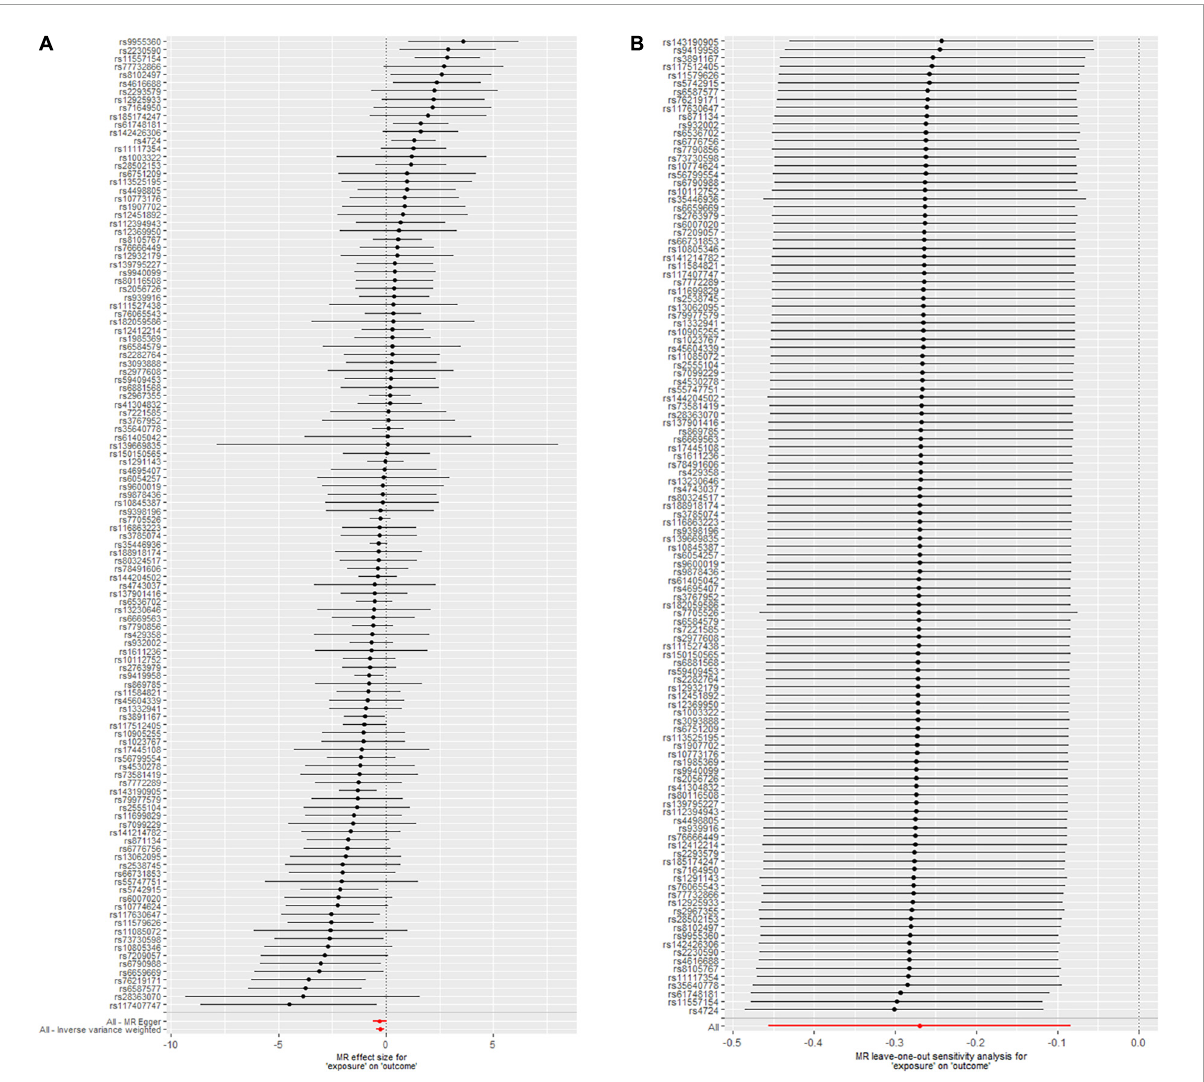
FIGURE2 Mendelian randomization (MR) leave-one-out sensitivity analysis (A) and forest plot (B) of the 118 telomere length (TL) single nucleotide polymorphisms (SNPs) associated with risk of calcific aortic valve stenosis (CAVS).